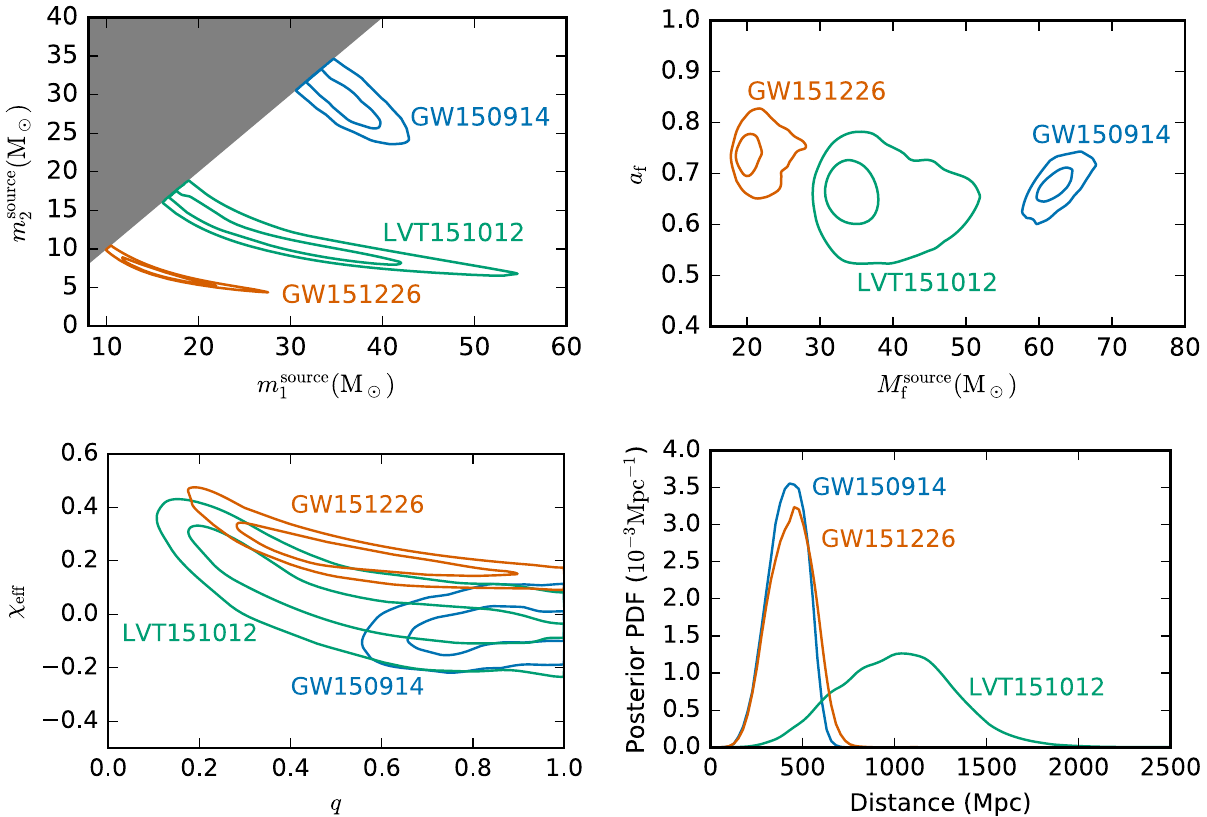
FIG. 4. Posterior probability densities of the masses, spins, and distance to the three events GW150914, LVT151012, and GW151226. For the two-dimensional distributions, the contours show 50% and 90% credible regions. Top left panel: Component masses m source 1 and m source m source ≥ m source 2 for the three events. We use the convention that 1 2 , which produces the sharp cut in the two-dimensional M ⊙ and distribution. For GW151226 and LVT151012, the contours follow lines of constant chirp mass ( M source ¼ 8 . 9 þ 0 . 3 − 0 . 3 M source ¼ 15 : 1 þ 1 . 4 − 1 . 1 M ⊙ , respectively). In all three cases, both masses are consistent with being black holes. Top right panel: The mass and dimensionless spin magnitude of the final black holes. Bottom left panel: The effective spin and mass ratios of the binary components. Bottom right panel: The luminosity distance to the three